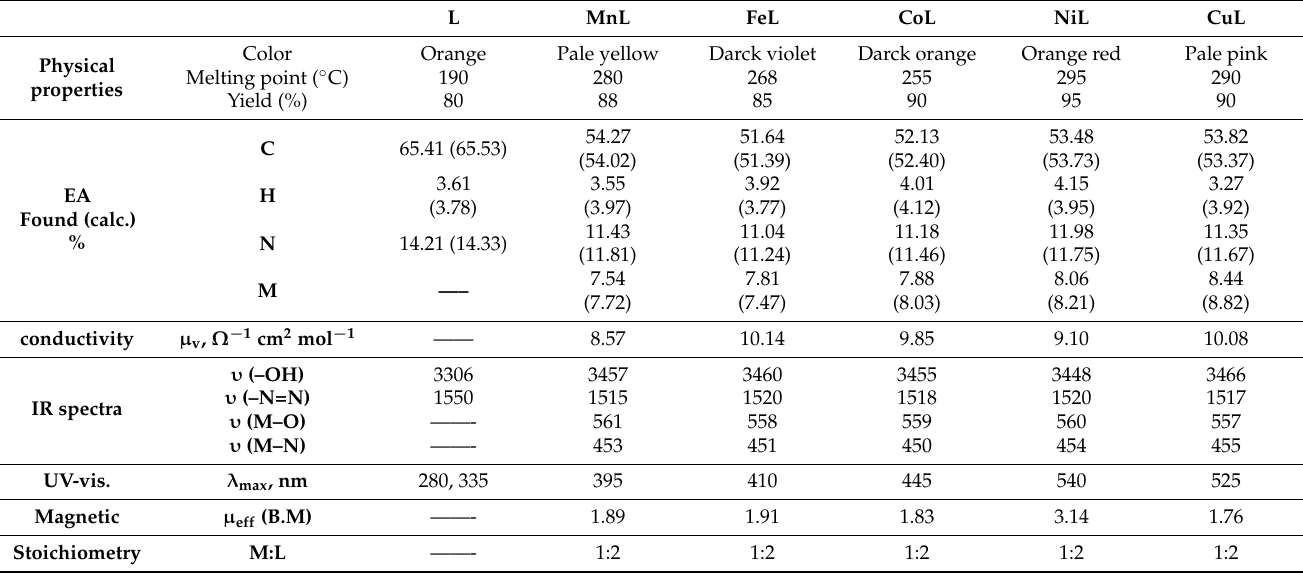
Table 1. EA, conductivity, Uv-vis, and FT-IR